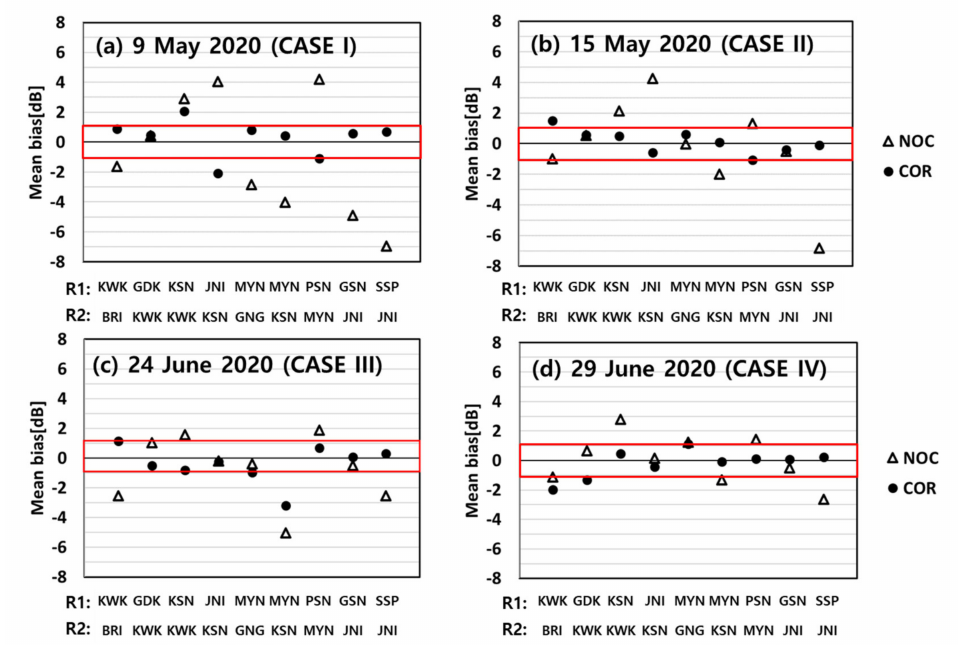
Figure 12. Mean bias of reflectivity between two radars for 4 rainfall events: ( a ) 9 May 2020, ( b ) 15 represents the matched radar. The triangle and dot indicate the mean bias before (triangle) and after (dot) calibration bias correction,